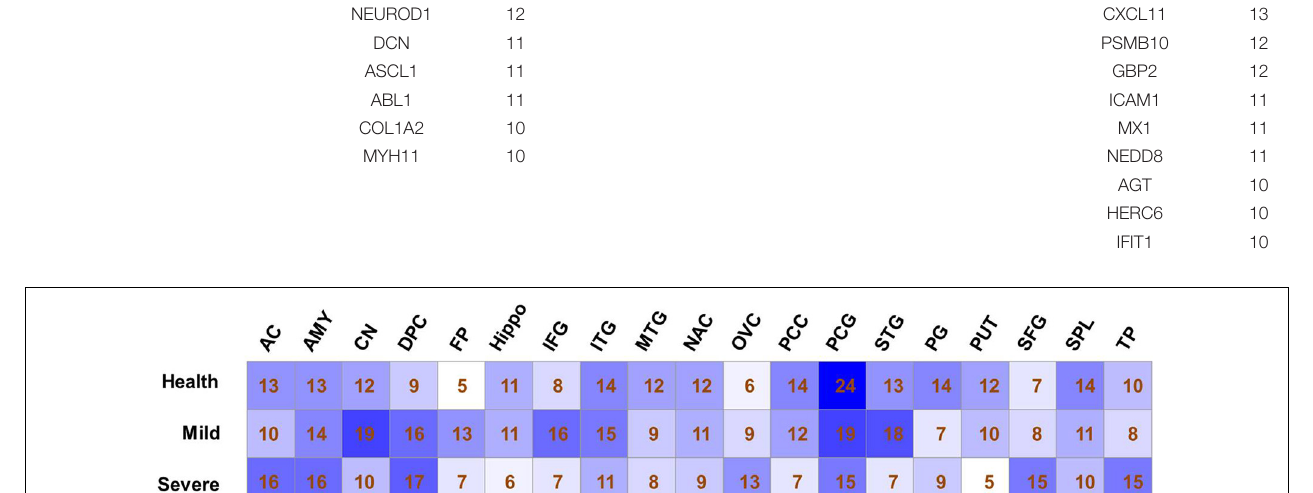
between them can be found, significantly ( P = 2.83E-14)